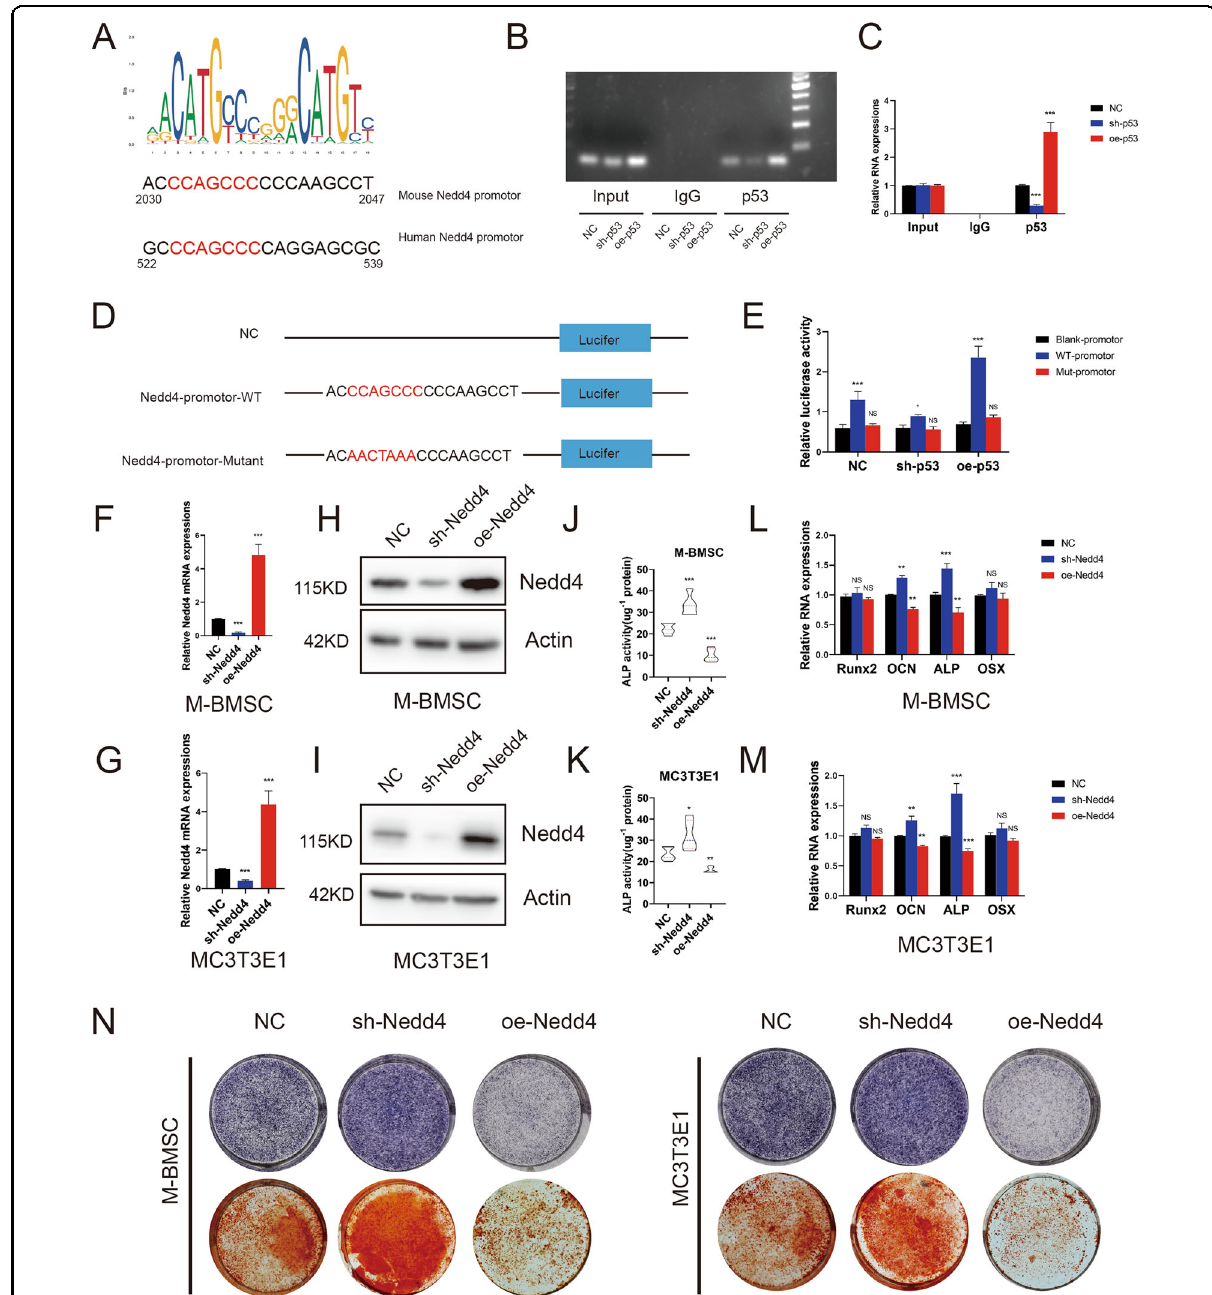
Fig. 6 P53 exerts its effects on bone mass by promoting Nedd4 promoter activity. A Schematic illustration of the p53-binding sequence and the promoter region of Nedd4 in mice and humans. B , C P53 binds to its binding sites in the Nedd4 promoter, as shown by the ChIP assay. Results are shown as mean ± SD; n = 5; *** P < 0.001 by analysis of variance (ANOVA) with Tukey ’ s post-hoc test. D Mutations in the putative p53-binding site in the Nedd4 promoter region. E Mutations in the binding site decreased luciferase activity in M-BMSCs. Results are shown as mean ± SD; n = 5; * P < 0.05, ** P < 0.01, and *** P < 0.001 by ANOVA with Tukey ’ s post-hoc test. F – I qRT-PCR and western blotting were used to measure the transfection ef fi ciency of Nedd4 in M-BMSCs and MC3T3-E1 cells. n = 5; *** P < 0.001 by ANOVA with Tukey ’ s post-hoc test. J , K Quantitative analysis of ALP activity. n = 5; * P < 0.05, ** P < 0.01, and *** P < 0.001 by ANOVA with Tukey ’ s post-hoc test. L , M qRT-PCR showing mRNA expression of Runx2, Alp, OCN, and OSX in M-BMSCs. Results are shown as mean ± SD; n = 5; ns ( P > 0.05), ** P < 0.01 and *** P < 0.001 by ANOVA with Tukey ’ s post-hoc test. N Representative images of ALP and ARS